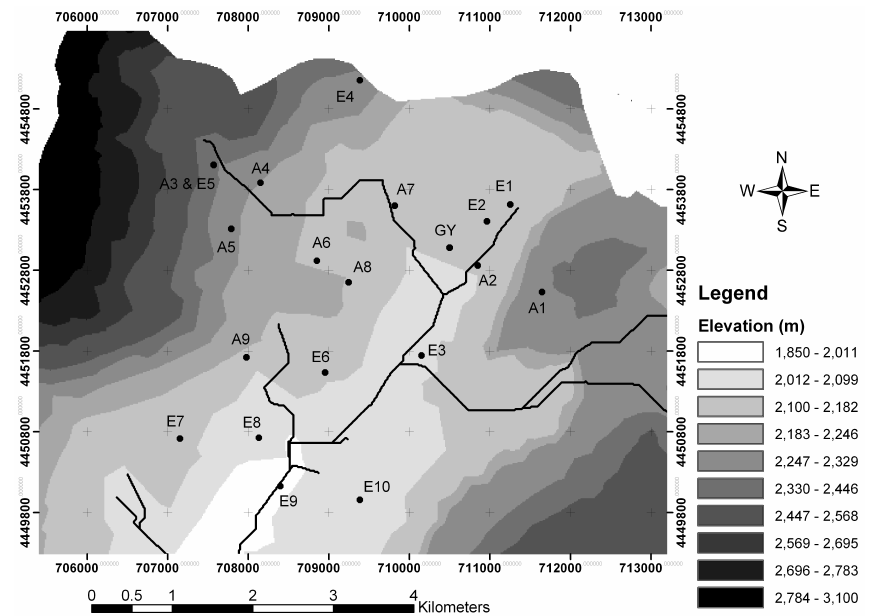
Fig. 3. Locations of snow and albedo measurements during 22–25 March 2004. Bad figure quality. Please submit a new